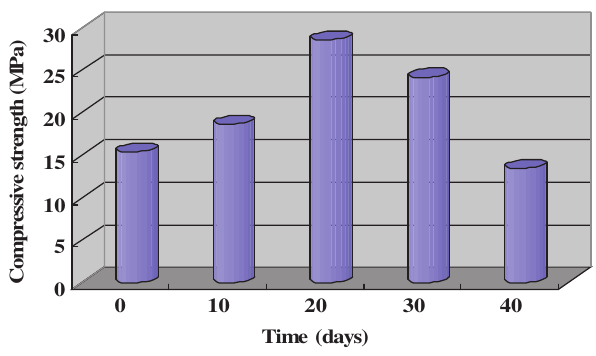
Figure 3: Compressive strength of cement bulk at different exposure times.